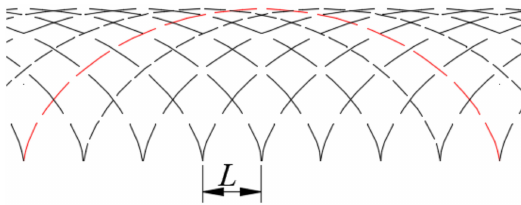
Figure 4. Definition of tine trajectory and parameters.